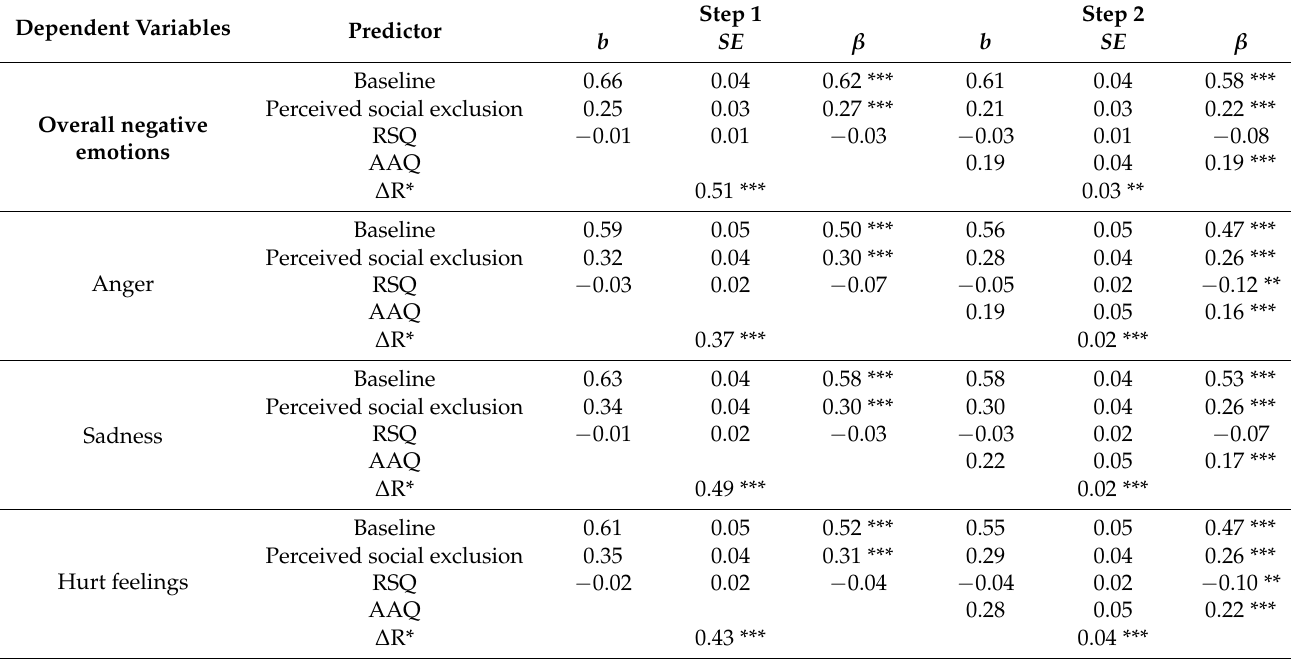
Table A1. The results of hierarchical multiple regression analysis of emotions after experiencing social exclusion to the trait